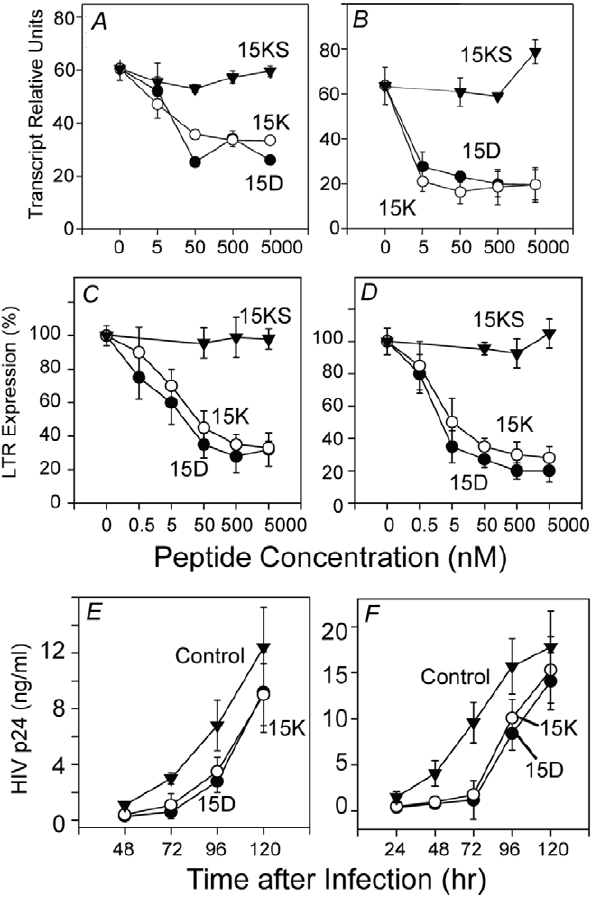
Figure 1. Inhibition of HIV-1 infection by peptides 15K, 15D, and the scrambled peptide 15KS using HIV-1 strain JRFL infection of purified monocytes (Panel A) or PBMCs (Panels C&E), or HIV-1 strain IIIB infection of purified CD4-positive T cells (Panel B) or PBMCs (Panel D&F). Cells were treated with the designated concentrations of peptide for a period of 1 h prior to addition of HIV-1 at an MOI of 0.1, or 500 nM peptide in Panels E&F. Four h after infection the cells were harvested and the HIV early replication was determined by PCR quantification of either strong-stop proviral R/U5 long-terminal repeat structures (Panels A& B), or at 18 hrs for the measurement of the 5 9 LTR (Panels C&D). The expression of HIV-1 p24 was also determined as a measure of HIV replication (Panels E&F). Results are presented for a representative experiment except for the data in Panels C and D where the collective data for all experiments are presented as the mean 6 SD for each data point.